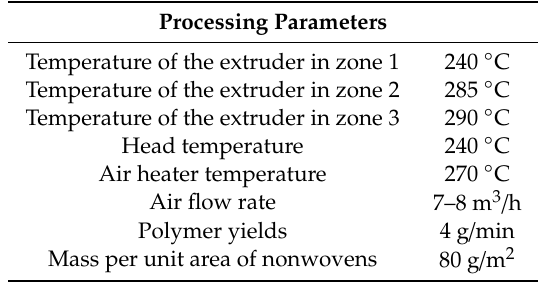
Table 3. Processing parameters applied for preparation of poly(propylene) (PP) composite nonwovens by melt-blown technique.